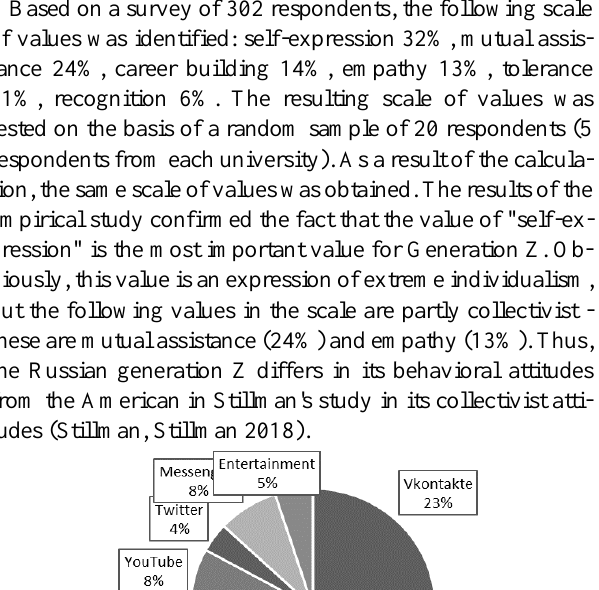
Figure 1. Behavioral attitudes of Generation Z